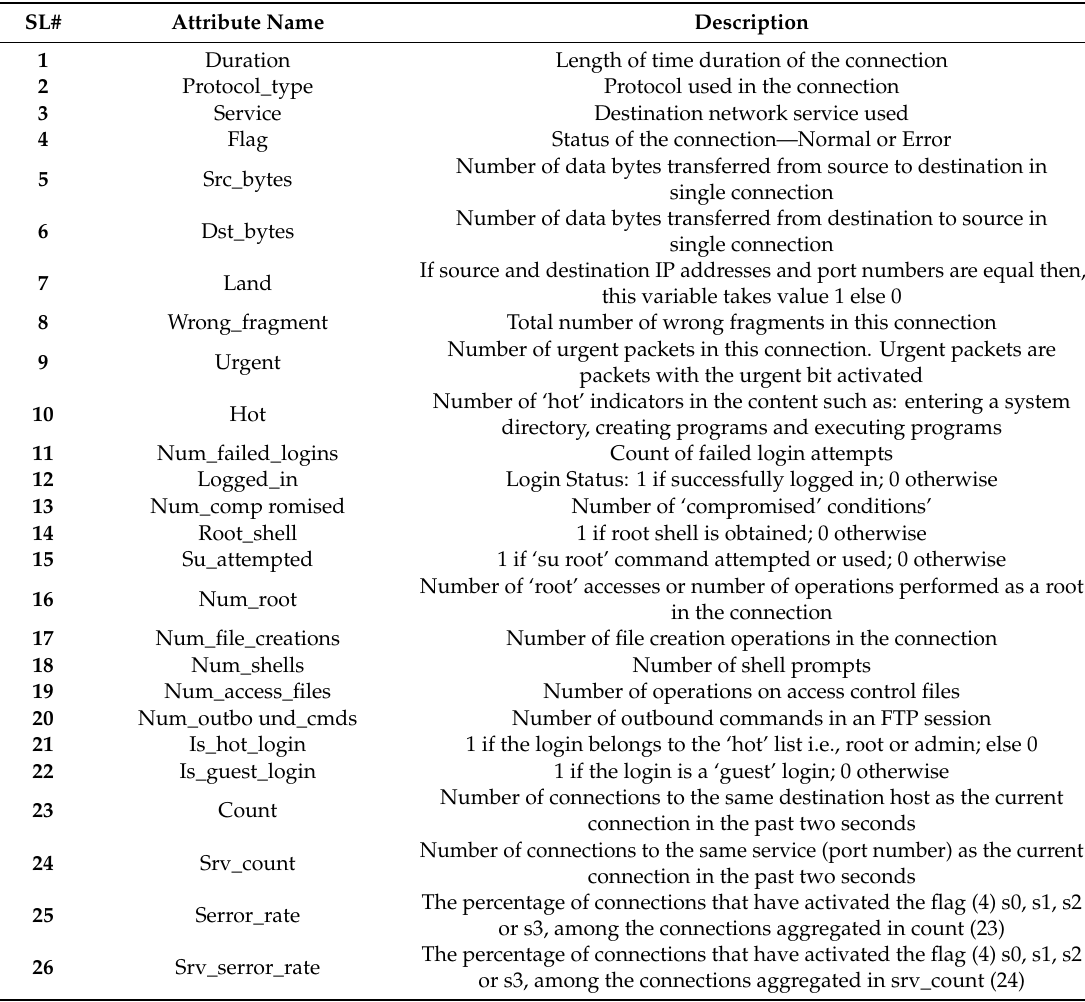
Table 8. NSL-KDD parameters [35]